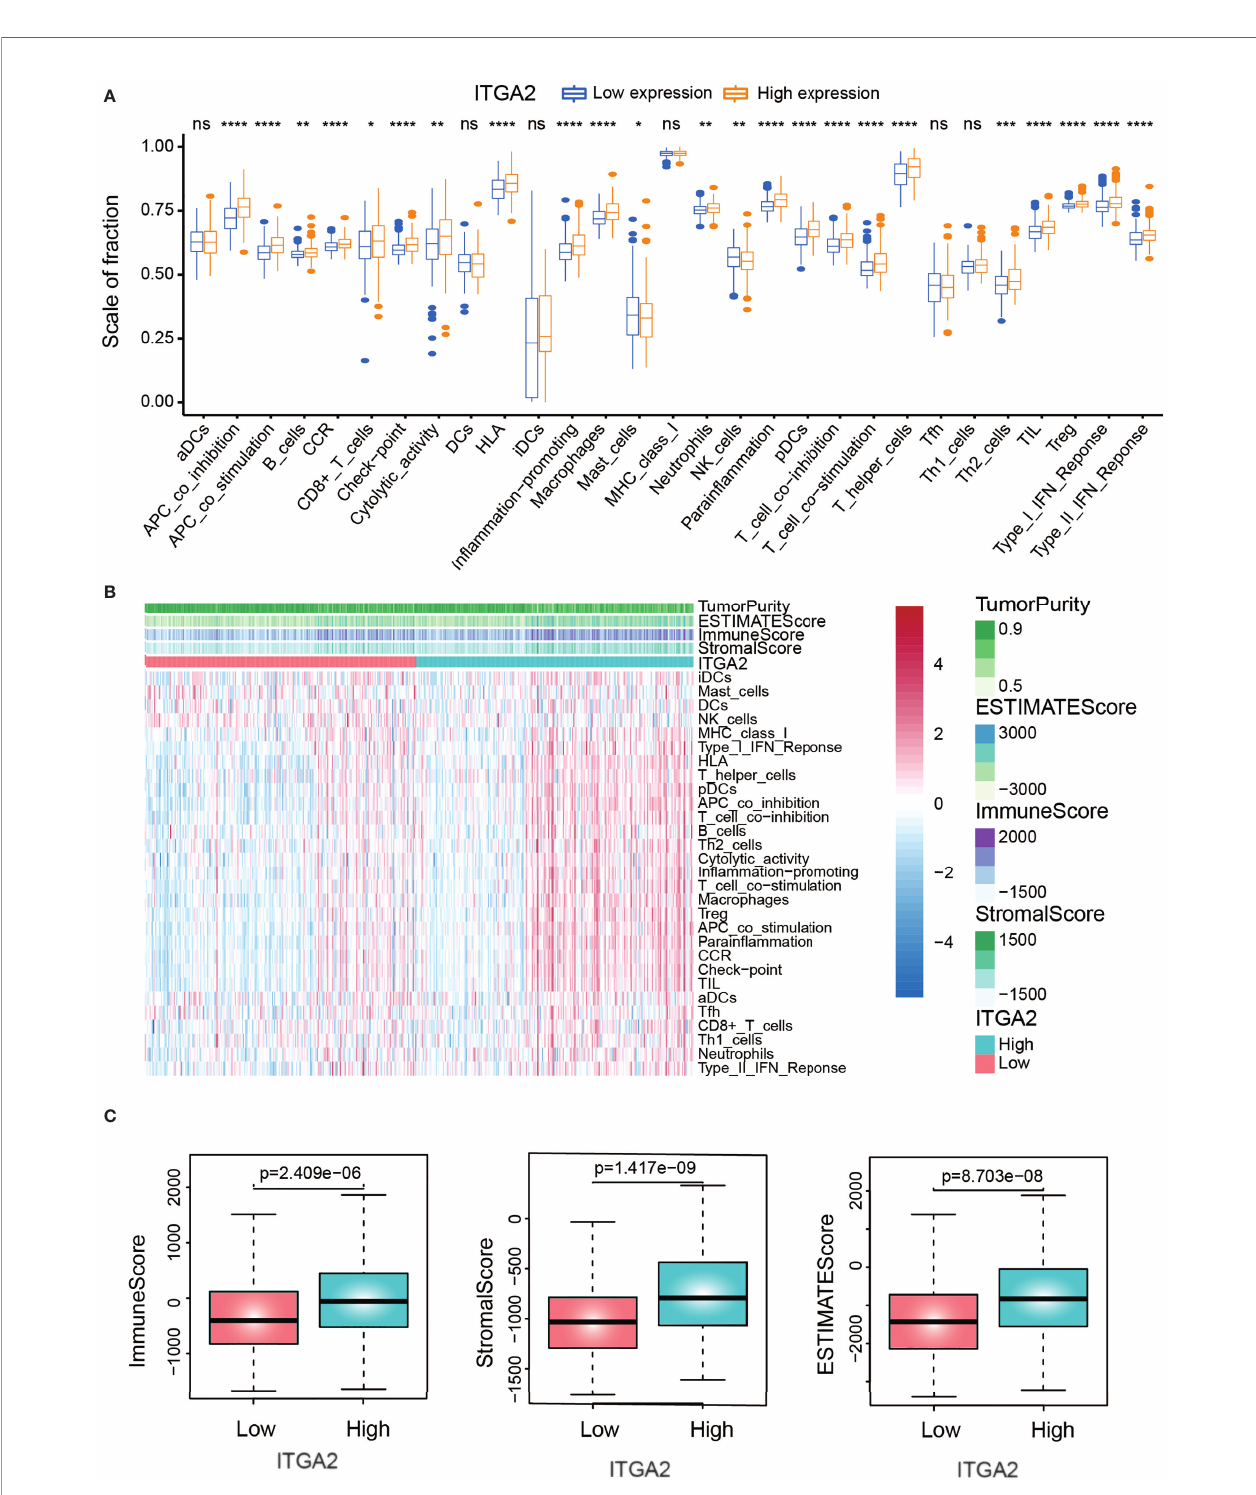
FIGURE 6 | The correlation analysis of immune in fi ltration. (A) The differences of immune-related cells between low-expression integrin alpha-2 (ITGA2) and high- expression ITGA2 groups. (B) Heat map demonstrating the correlation between the expression of the ITGA2 genes and immune in fi ltration. (C) Correlation analysis between the expression of the ITGA2 gene and immune-related score (immune score, stromal score, and estimate score). *p < 0.05, **p < 0.01, ***p < 0.001, ****p < 0.0001. ns (